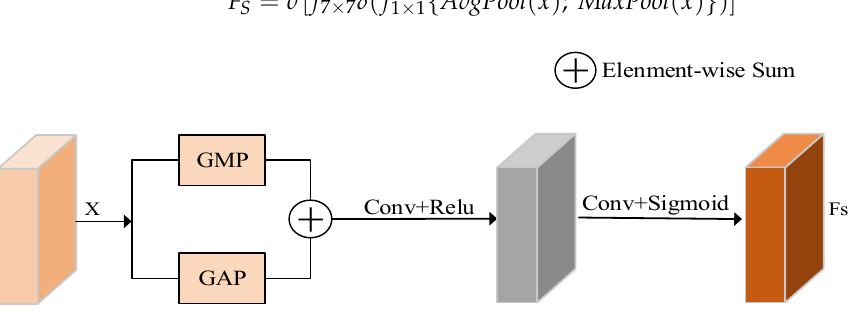
Figure 4. Spatial attention block.